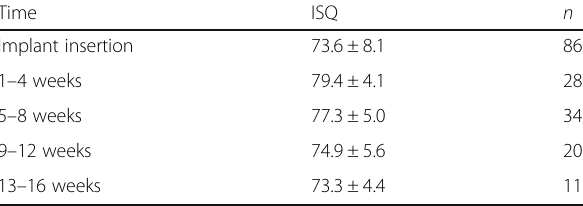
Table 5 Resonance frequency